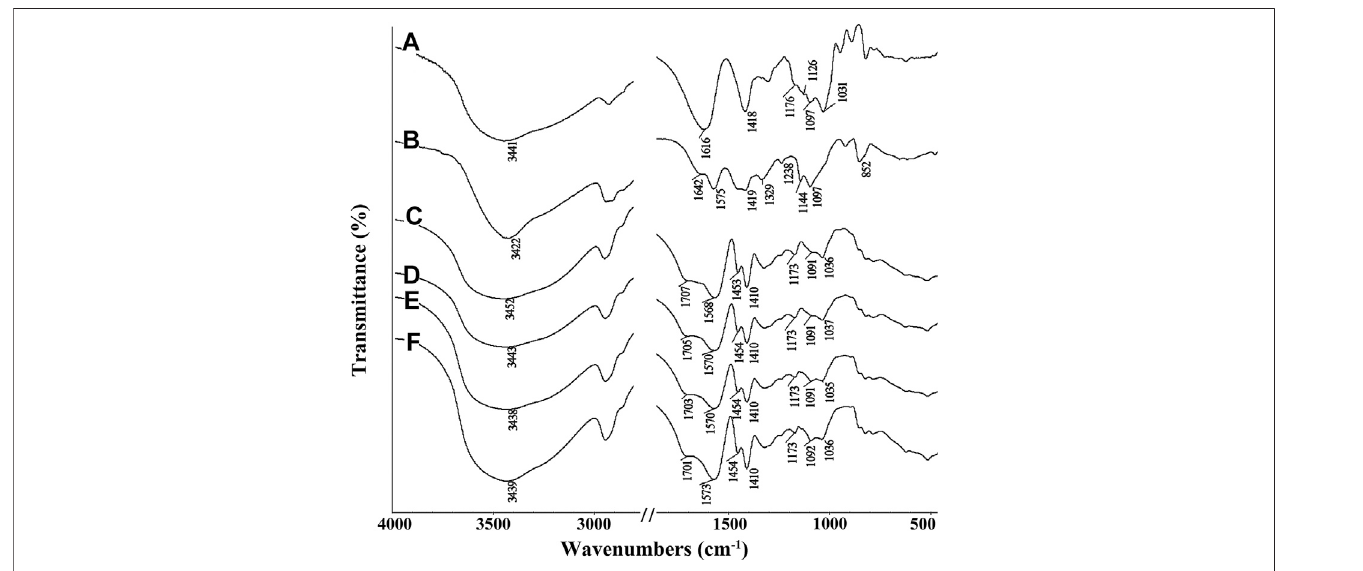
FIGURE 1 | FTIR spectra of (A) SA, (B) PVA, (C) Semi-IPN2, (D) Semi-IPN5, (E) Semi-IPN10, (F)